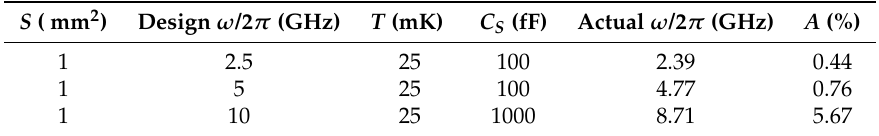
Table 2. Qubit designs with a series capacitor S = 1 mm 2